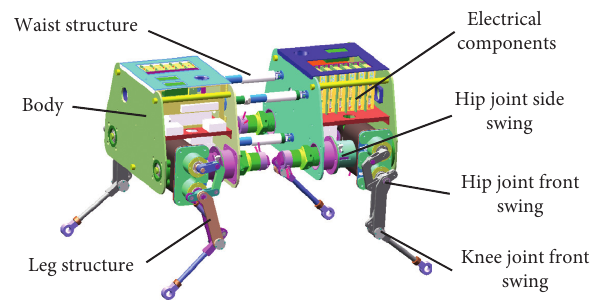
Figure 1: Quadruped robot